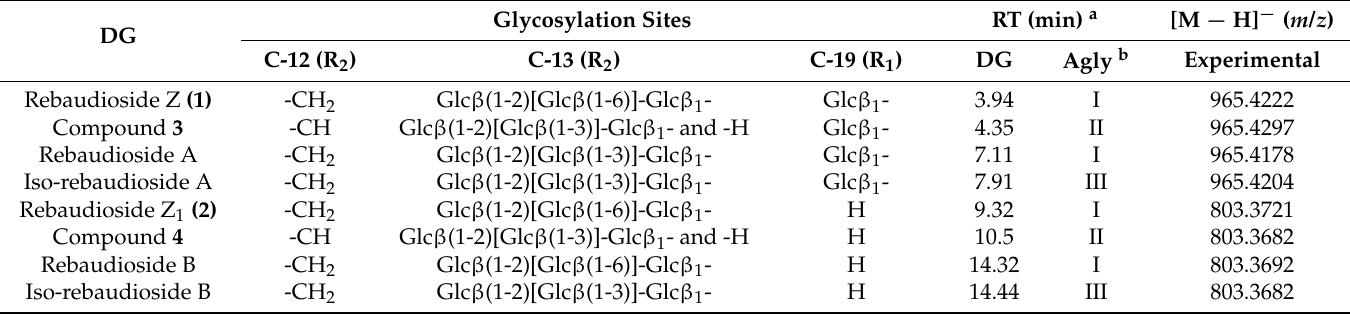
Table 3. Glycosylation sites, sugar arrangements, HPLC retention times, molecular weights and type of aglycones of rebaudioside A and B